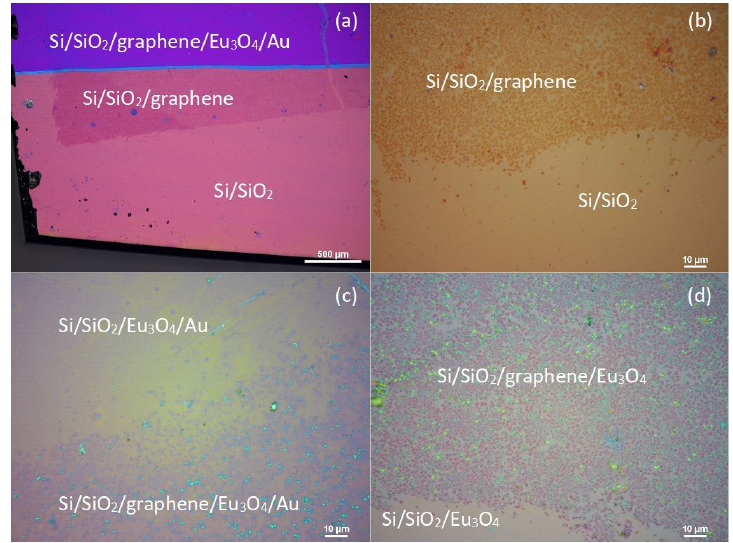
Figure 7. The microscopic optical images of the Si/SiO 2 /graphene/Eu 3 O 4 /Au sample highlighting the different regions of the surface of the sample. ( a ) the bare and coated area of the Si/SiO 2 substrate before the etching process, ( b ) a zoomed-in view of the surface using a 100X objective lens showing the mixed domain structures of the graphene underlayer, ( c ) the graphene under the Eu 3 O 4 layer before and ( d ) after etching the Au capping